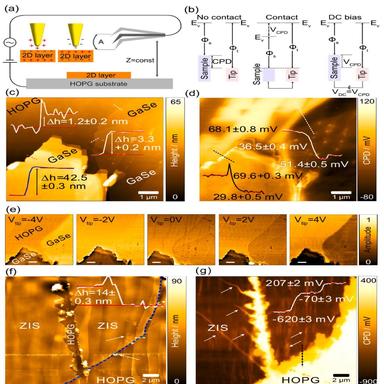
a) General schematic of KPFM and SCM modes measurement setup. b) KPFM energy diagram. c) AFM topography image of GaSe on HOPG (inset height profile). d) CPD image of GaSe on HOPG (inset - CPD profile). e) SCM imaging GaSe layers at different applied DC voltages; the scale bar is 2 µm. f) AFM topography image of Zn2In2Z5 on HOPG (inset - height profile). The blue-dashed line shows the ZIS/HOPG interface. g) CPD image of ZIS. White arrows show contamination, inset - CPD profile. (For interpretation of the ref